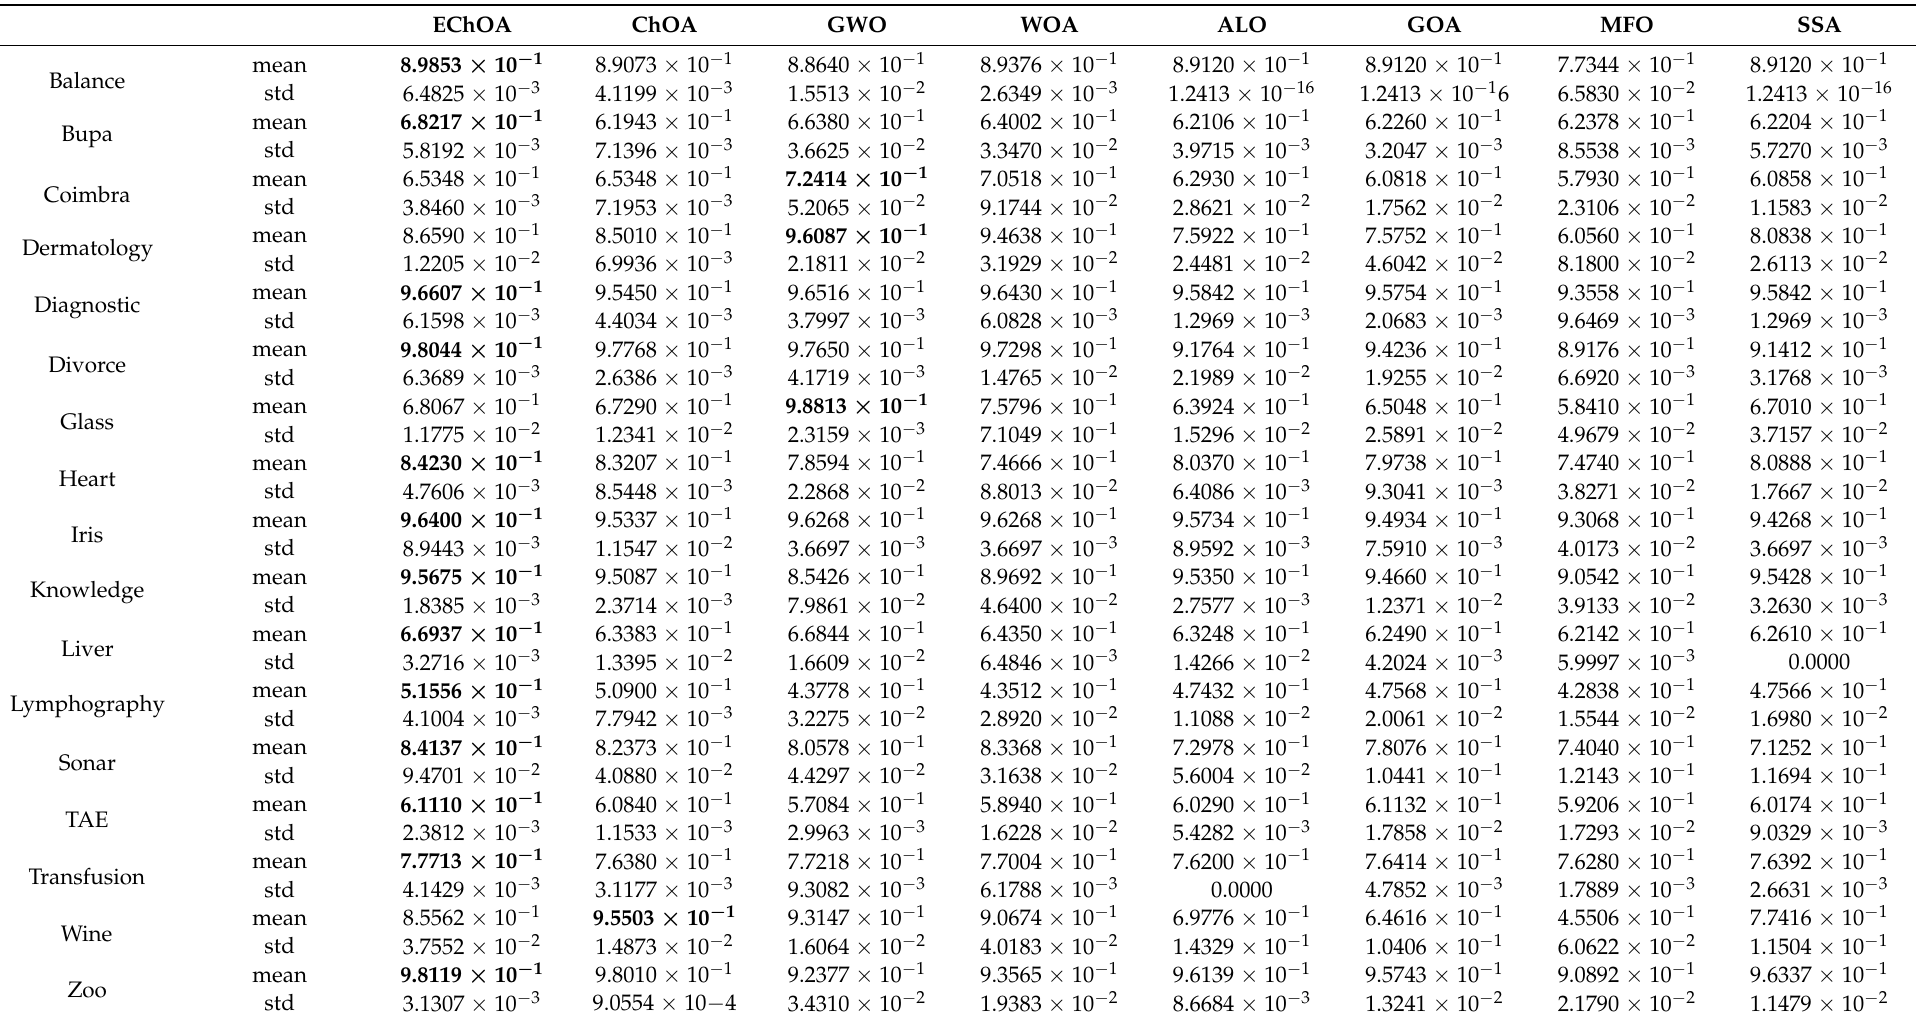
Table 3. Mean and standard deviation of classification accuracy for all data sets with applying feature